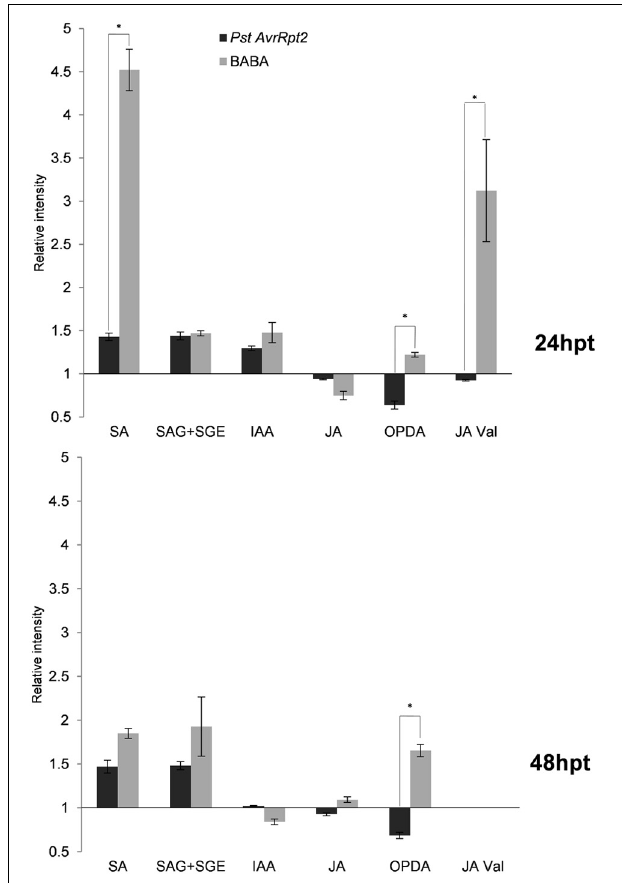
FIGURE 5 | Levels of hormones and conjugates after 24 and 48hpt. The abundance of every compound was calculated as in Figure 2 . Asterisks represent statistically significant differences (Wilcoxon Mann–Whitney test, p < 0 . 05, n = 6). Data represent average of three independent experiments.